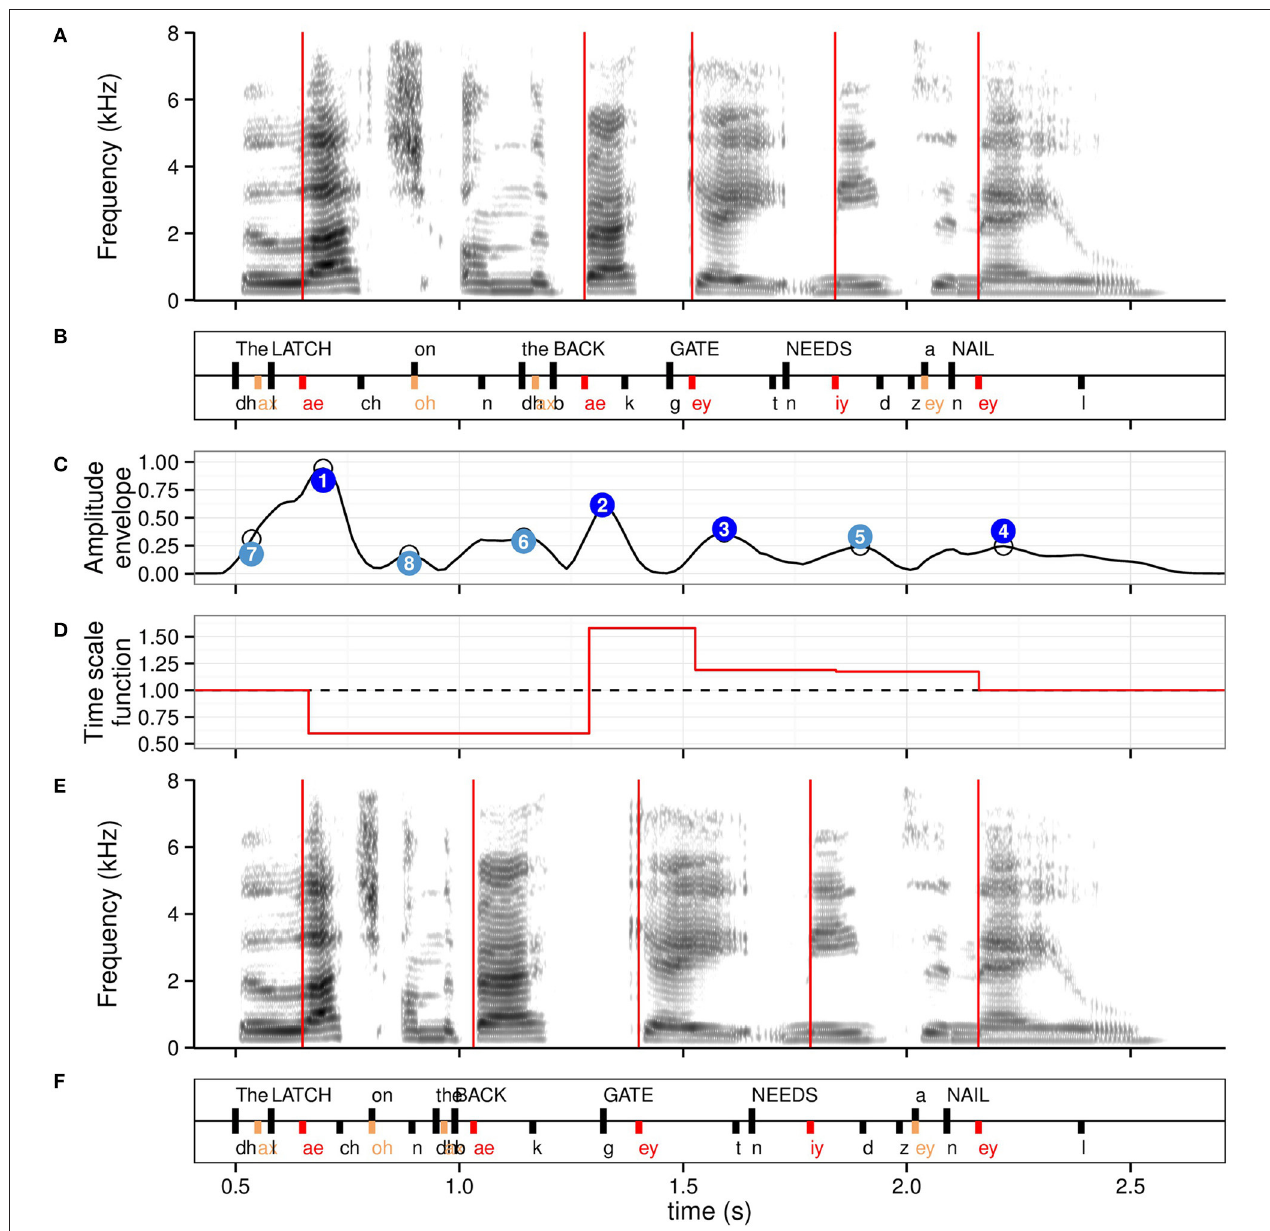
FIGURE 1 | Anchor points used for the isochronous modification, with the associated time scale function for the stressed syllable level for the example sentence The latch on the back gate needs a nail . (A) Spectrogram of the naturally timed sentence, with time instants of stressed syllables onsets overlaid in red. (B) Annotation in words (scored keywords in capital letters) and phonemes. Stressed syllables are in red, unstressed syllables in orange, remaining phonemes, and word onsets in black. (C) Amplitude envelope in normalized units with original peaks identified with empty circles. Peaks adjusted for sentence-level decay are shown in numbered circles with numbers indicating decreasing value order. Dark blue: four highest peaks; light blue: remaining peaks up to height. Note the relative agreement in timing between stressed syllables and low number of amplitude envelope peaks anchor points. (D) Time scale function for the stressed syllables anchor points. Values < 1 indicate compression, values > 1 elongation. (E) Spectrogram of resulting isochronous sentence at the stressed syllable level, with time instants of isochronous stressed syllables onsets overlaid in red. (F) Resulting isochronous